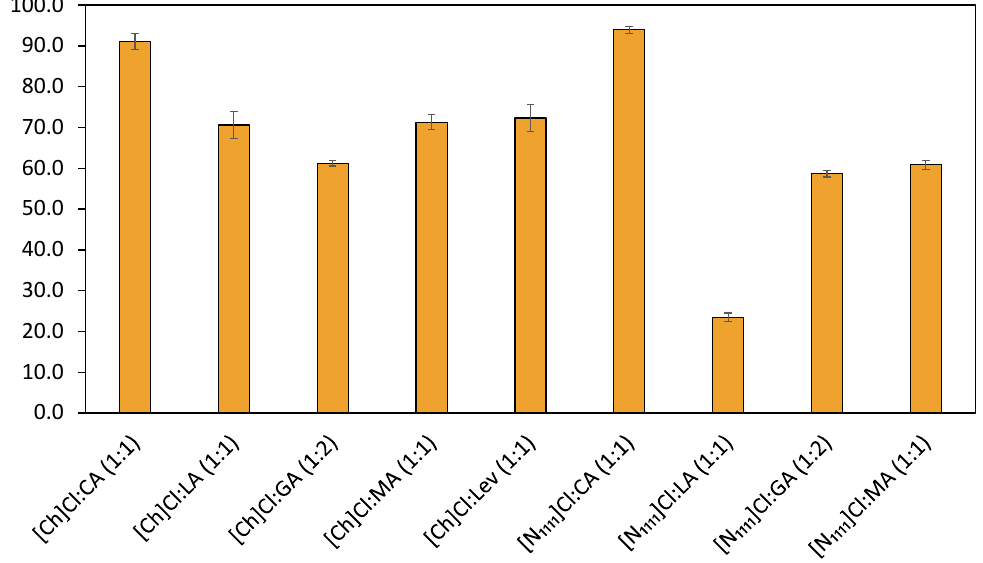
Figure 2. 5-HMF yields attained for different DES at 120 °C, 2 min of reaction time with microwave heating and S/L ratio of 0.05.